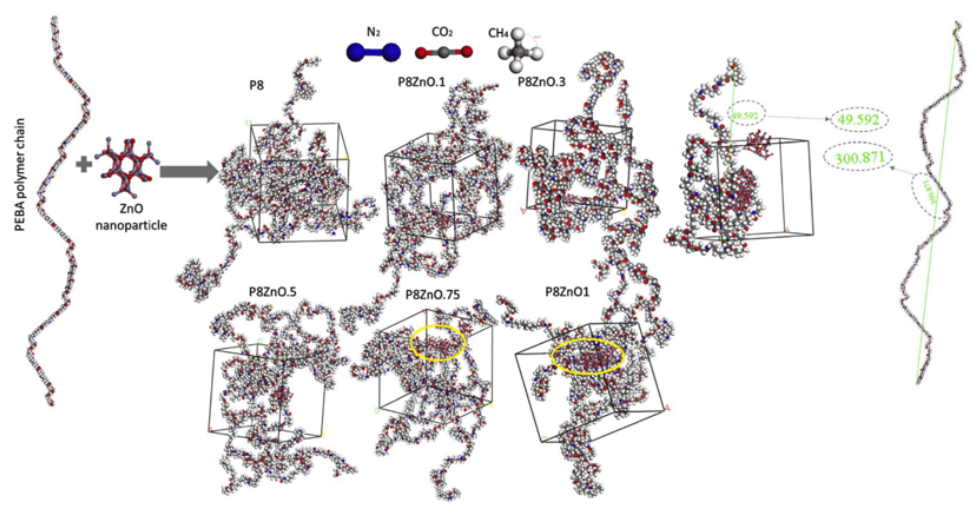
Figure 8. The construct procedure of PEBA chains and membranes [56].